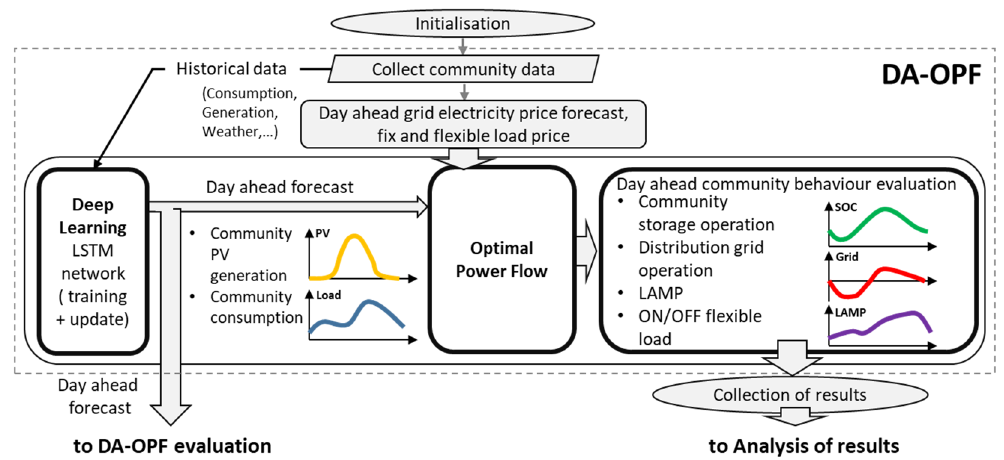
Figure 1. The flowchart of the developed smart-community microgrid (SCM) operation method—day-ahead optimal power flow (DA-OPF).